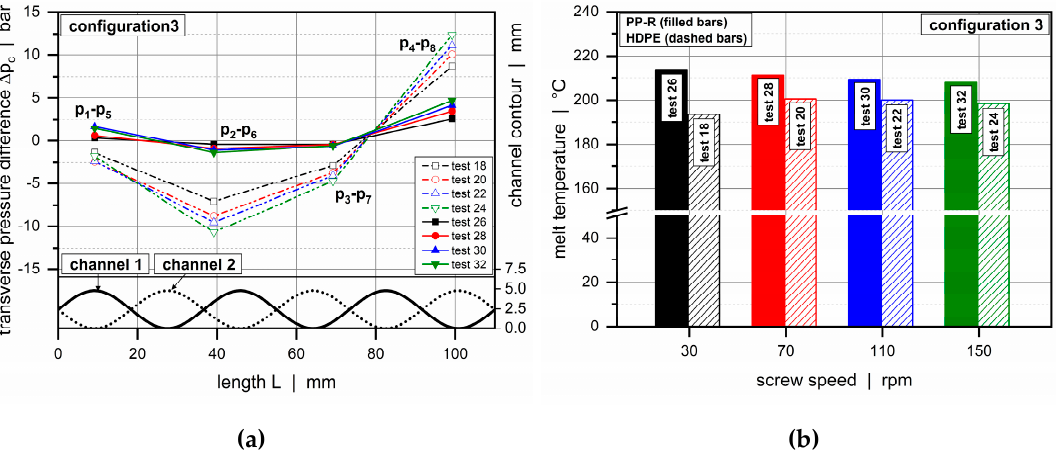
Figure 17. Influence of viscosity behavior. Transverse pressure difference between channel 2 and channel 1 ( a ) and melt temperatures ( b ) for configuration 3.